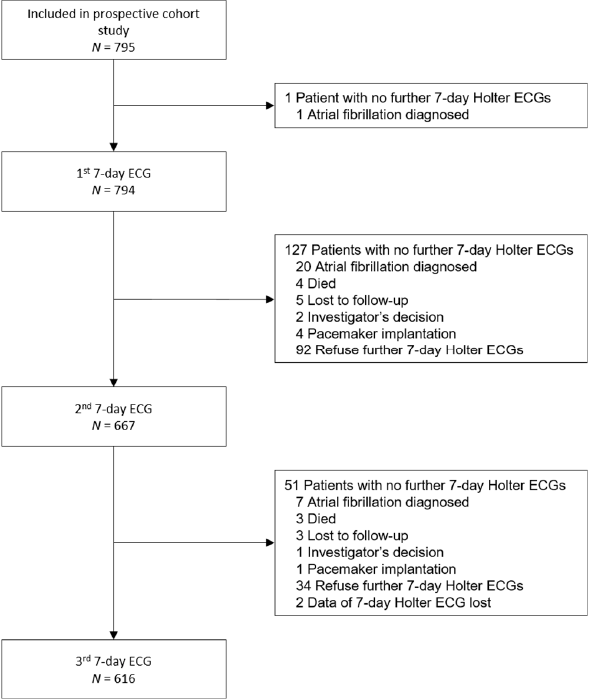
Figure 2. Flow chart showing the number of 7-day Holter ECGs performed in the cohort study and reasons for not completing three 7-day Holter